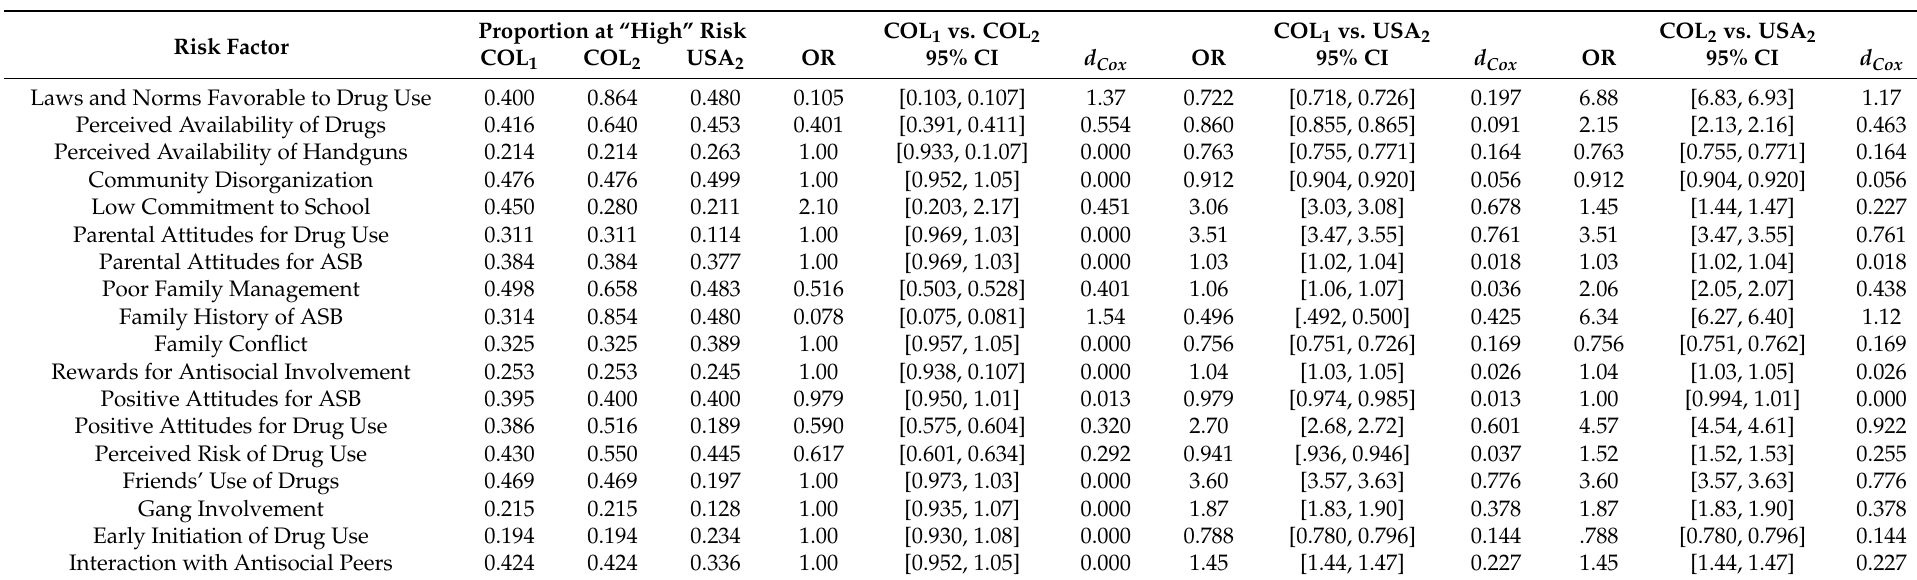
Table 1. Comparison of proportions of sixth-grade students at “high” risk, odds ratios, 95% confidence intervals, and effect sizes using Colombian and United States cut-points. Risk